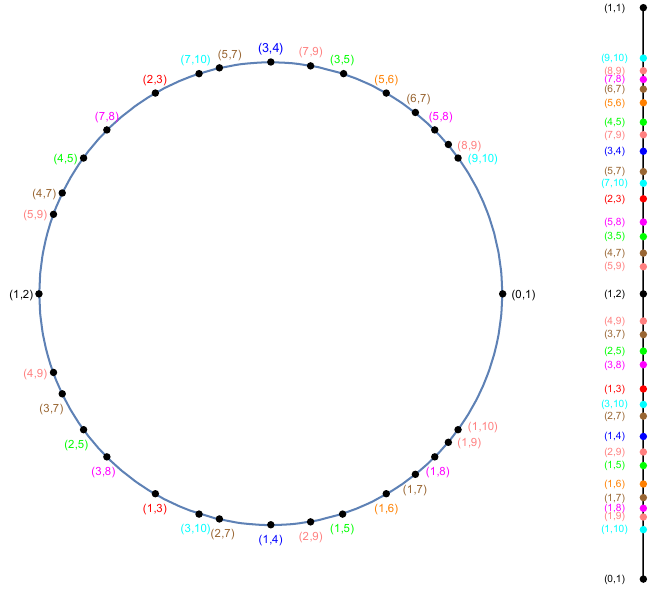
Figure 7. Farey sequence of bifurcation points λ (cid:96) , q